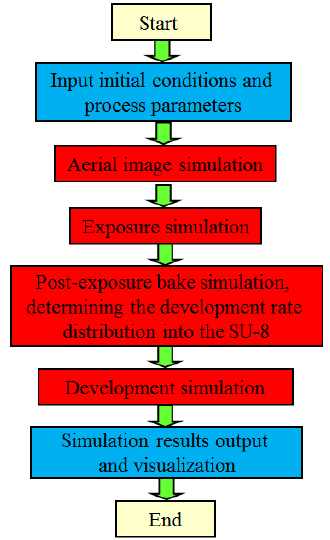
Figure 2. Simulation flow chart for the ultraviolet (UV) lithography of SU-8.